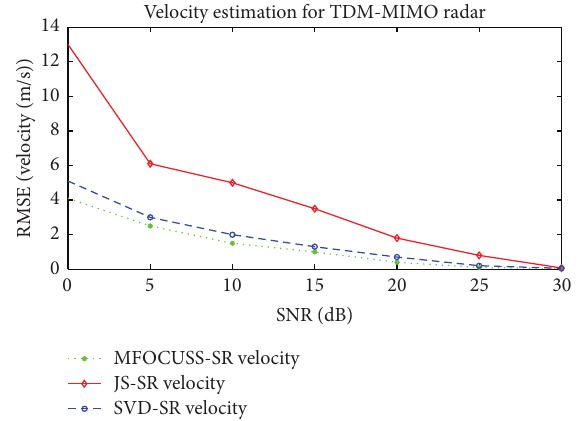
Figure 6: Velocity estimation for TDM-MIMO radar.